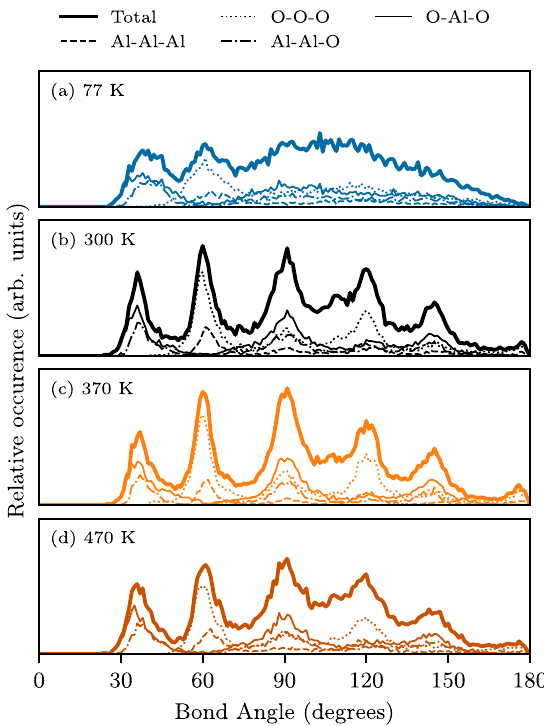
Fig. 6 The effect of temperature on the bond angles in the completed oxide structures. Bond angles in the surface oxide following simulated oxidation at temperatures of ( a ) 77, ( b ) 300, ( c ) 370, and ( d ) 470